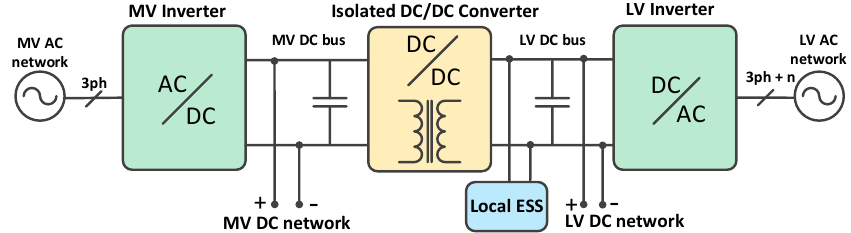
Figure 2. Smart Transformer—overall structure of the developed computational